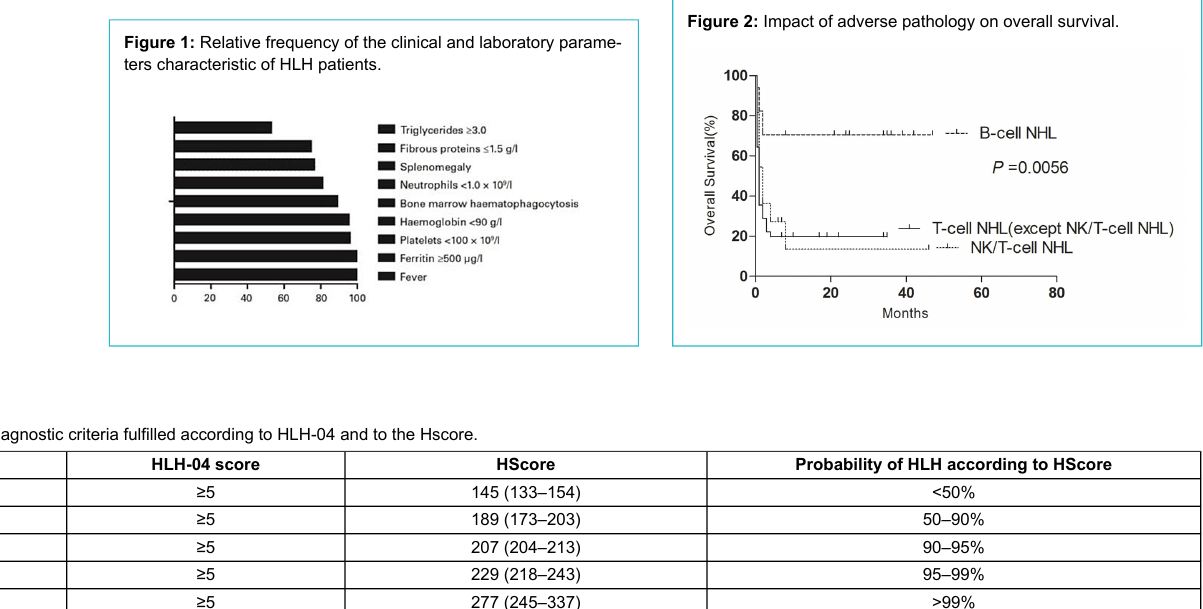
Figure 2: Impact of adverse pathology on overall survival.